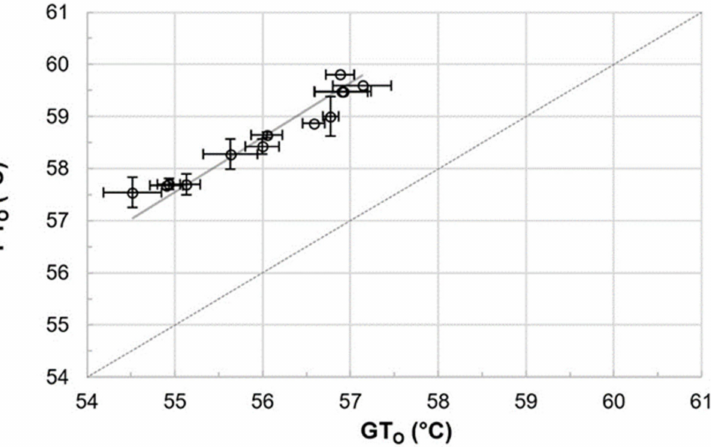
Figure 2. Comparison of and correlation between gelatinization onset (GT O ) and pasting onset (PT O ) temperatures ( r = 0.97). Data points refer to mean values and error bars represent the standard deviation. The dotted line is the bisecting